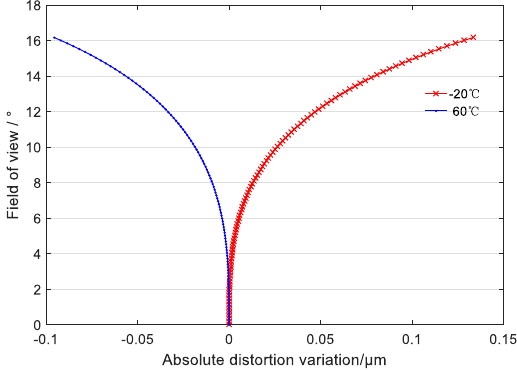
Figure 12. Curve of absolute distortion variation with temperature.